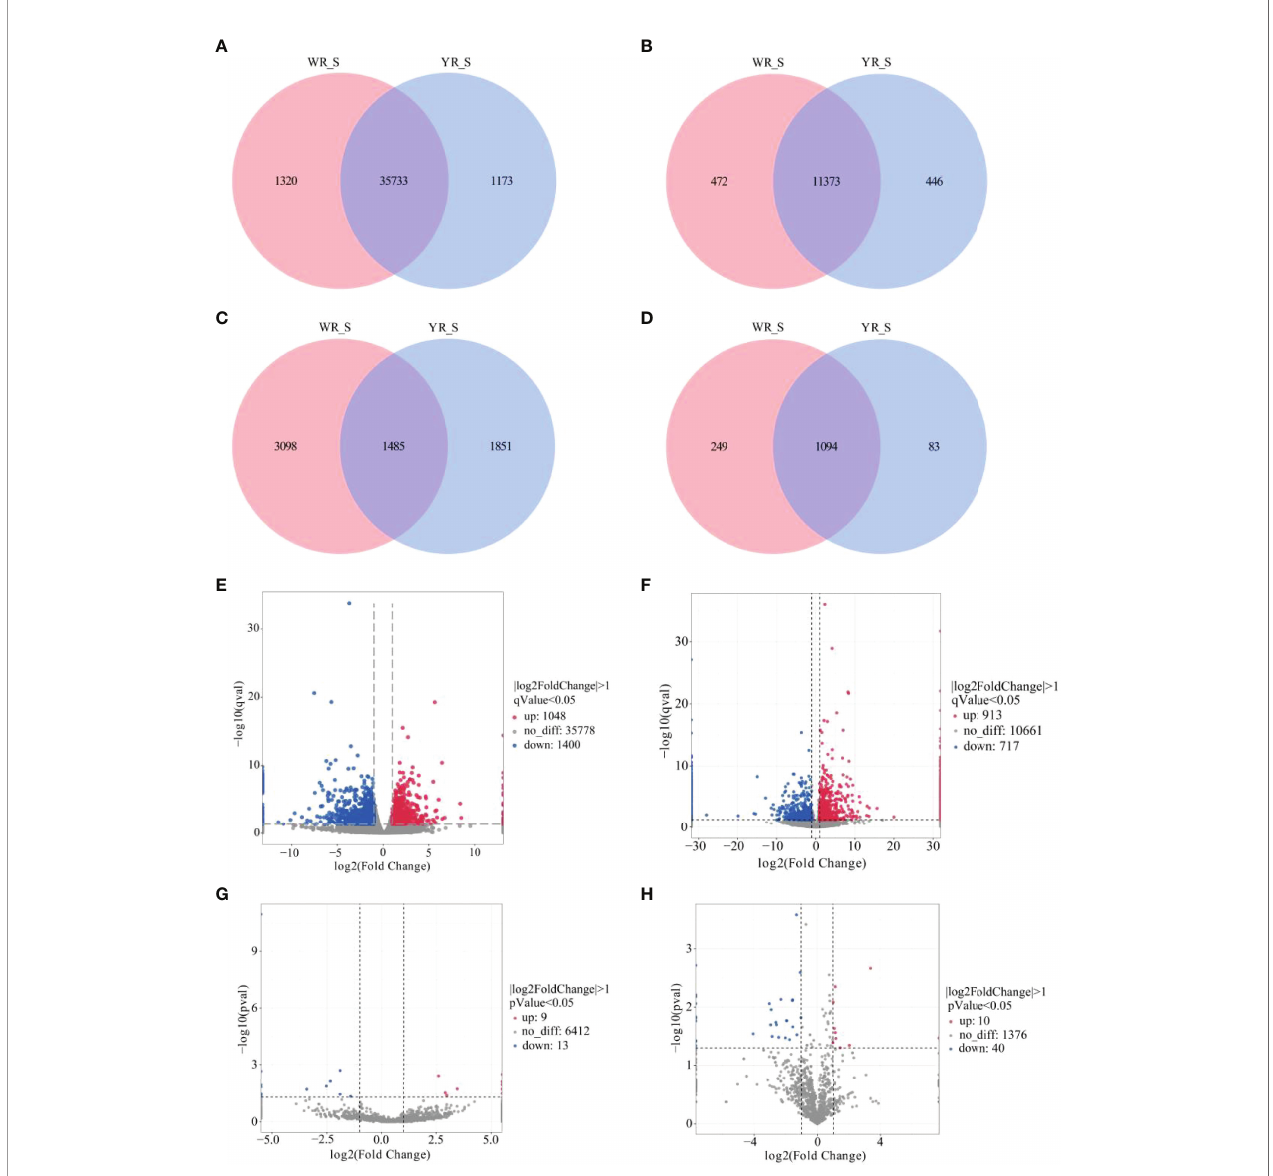
FIGURE 2 | Comparative analysis of mRNA and ncRNAs between WR_S and YR_S groups. (A) mRNAs, (B) lncRNAs, (C) circRNAs and (D) miRNAs expressed only in WR_S (pink circle), only in YR_S (blue circle), and co-expressed in both WR_S and YR_S (intersection). (E) Volcano plot of differentially expressed DE mRNAs. (F) Volcano plot of DElncRNAs. (G) Volcano plot of DEcircRNAs. (H) Volcano plot of